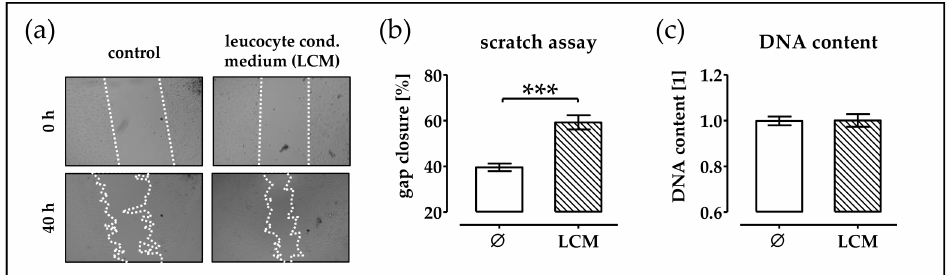
Figure 1. Leucocyte-conditioned medium (LCM) stimulates migration of primary human osteoblast (phOBs). In order to investigate the influence of LCM on phOBs ( N ≥ 4, n ≥ 4), migration scratch assays are performed in the presence or absence of LCM. ( a ) Representative microscopic images for the scratch assay (20 × magnification). ( b ) Gap closure is determined from microscopic images (100 − gap area 40h /gap area 0h × 100) with the help of the ImageJ software. ( c ) Total DNA content is measured with the help of Hoechst33342. Data are represented in bar diagrams (mean ± 95% C.I.). *** p < 0.001 as